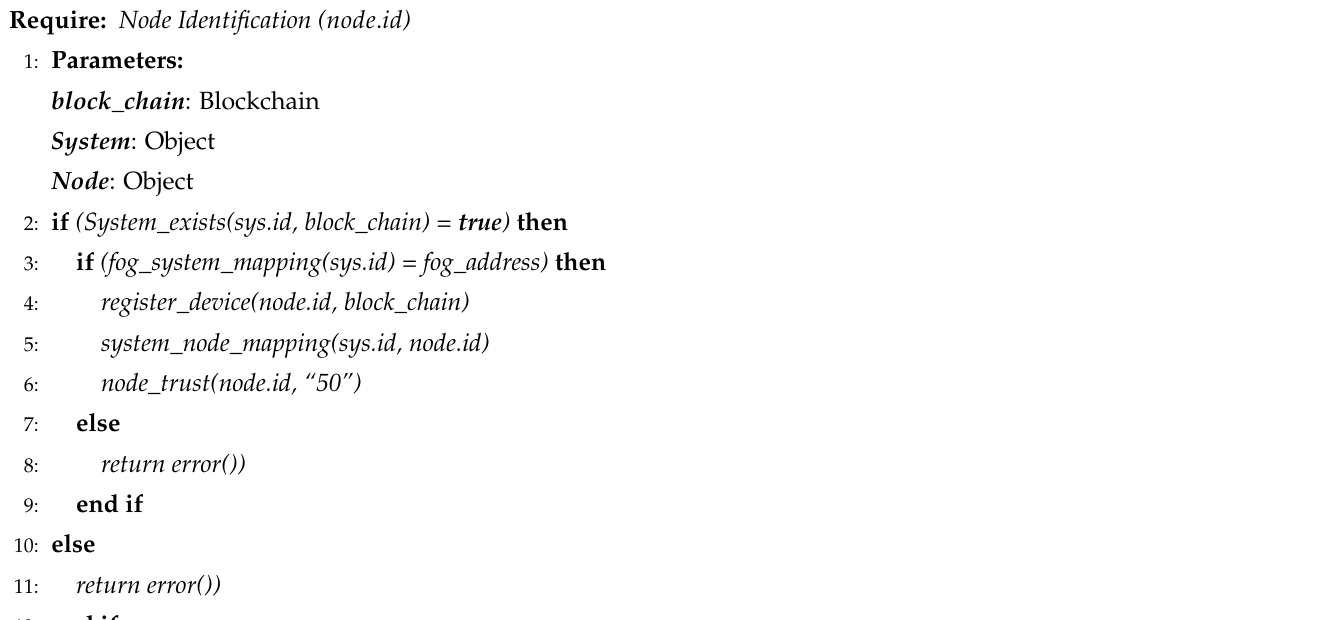
Algorithm 2 Sensor node registration rules for smart contract